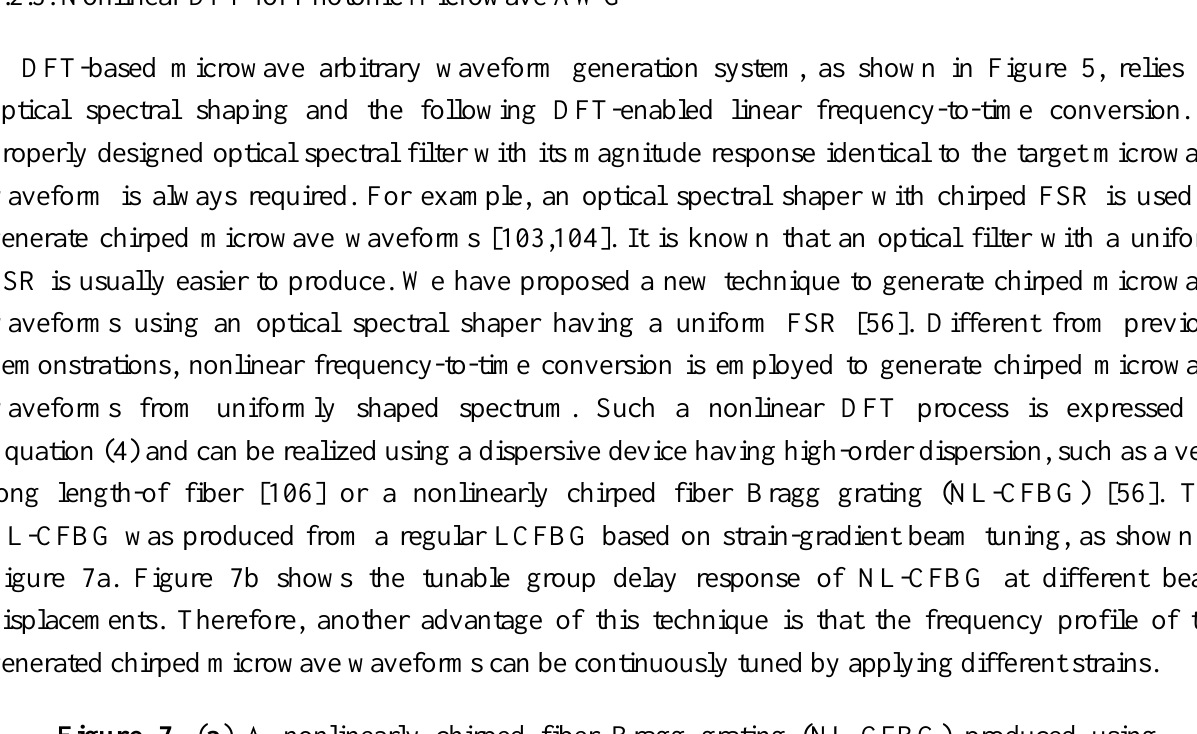
Figure 7. ( a ) A nonlinearly chirped fiber Bragg grating (NL-CFBG) produced using strain-gradient beam tuning. ( b ) Simulated group delay characteristics of the produced NL-CFBG at different beam